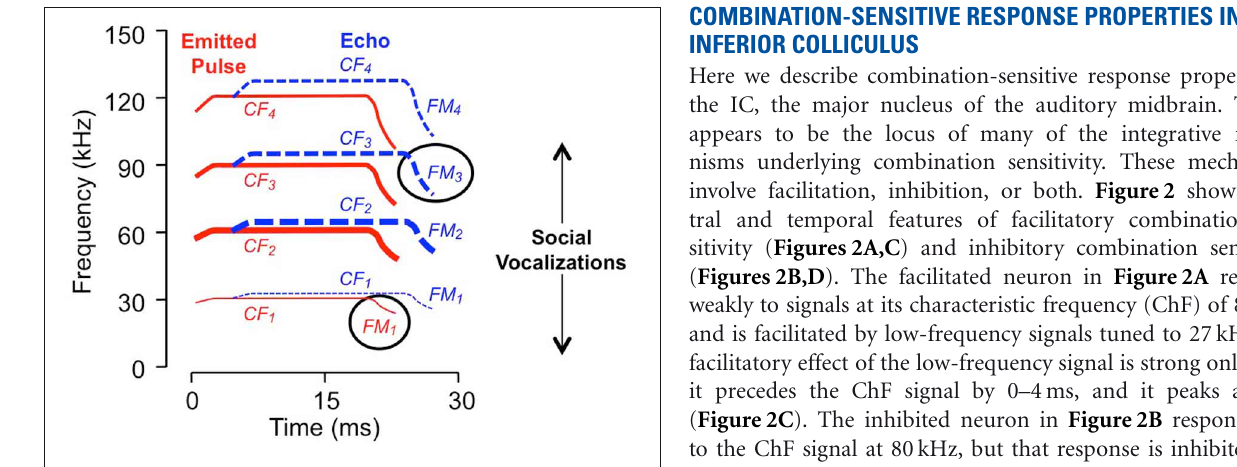
FIGURE 1 | Spectral and temporal features of vocalizations. Schematic sonogram of echolocation signal displays emitted pulse (in red) and a Doppler (frequency) shifted and time delayed echo (in blue). Each signal is composed of CF, constant frequency; FM, frequency modulated components, with several harmonic elements (e.g., FM 1 , FM 2 , etc.). Line thickness indicates relative intensity: the second harmonic of the emitted pulse, near 60kHz, is the most intense while the fundamental is usually less intense than either the second or third harmonics. Ovals indicate sonar elements to which the neurons in Figure 2 are tuned. Social vocalizations span the range from approximately